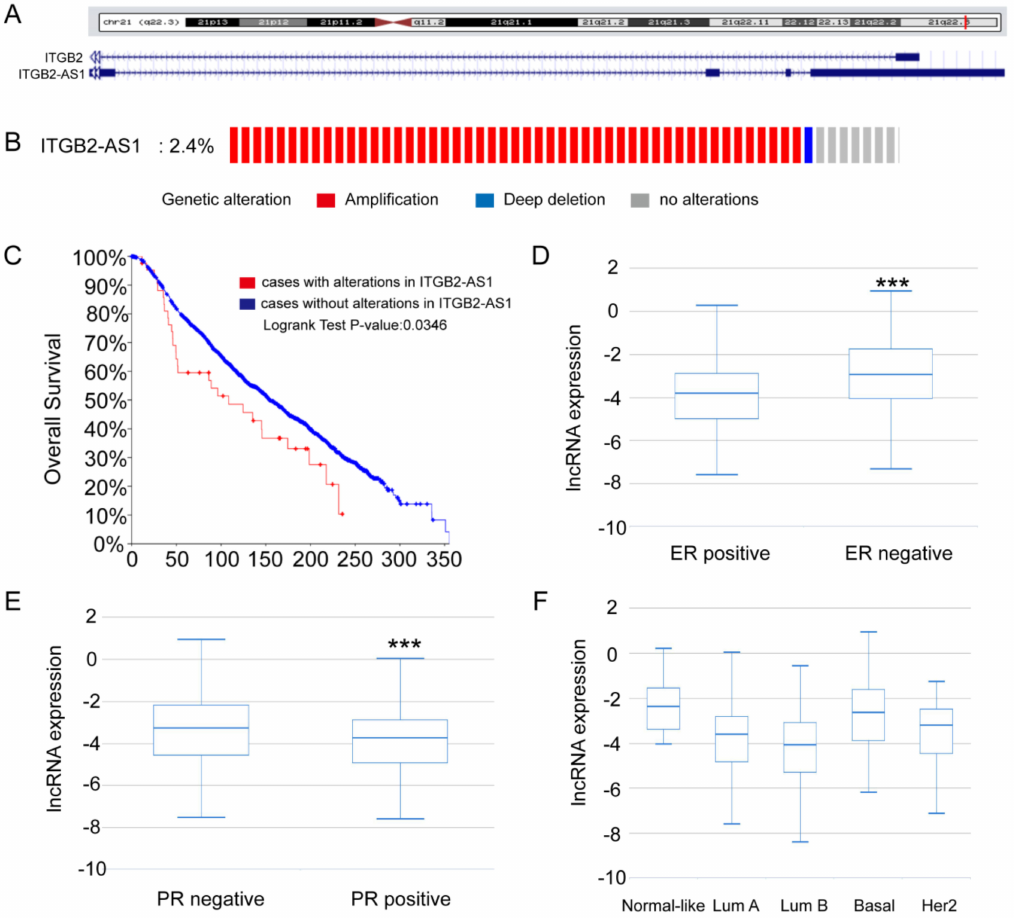
Figure 1. The expression analysis of ITGB2-AS1 on online database. ( A ) The gene location in UCSC genome website; ( B )The proportion of genetic alteration in METABRIC sub-database on cBioPortal website; ( C ) The overall survival curve of METABRIC sub-database on cBioPortal website; ( D ) The expression of ITGB2-AS1 in ER-positive and ER-negative breast cancer samples of TANRIC database; ( E ) The expression of ITGB2-AS1 in PR-positive and PR-negative breast cancer samples of TANRIC database; ( F ) The expression of ITGB2-AS1 in five pathological types of breast cancer in TANRIC database. *** p <